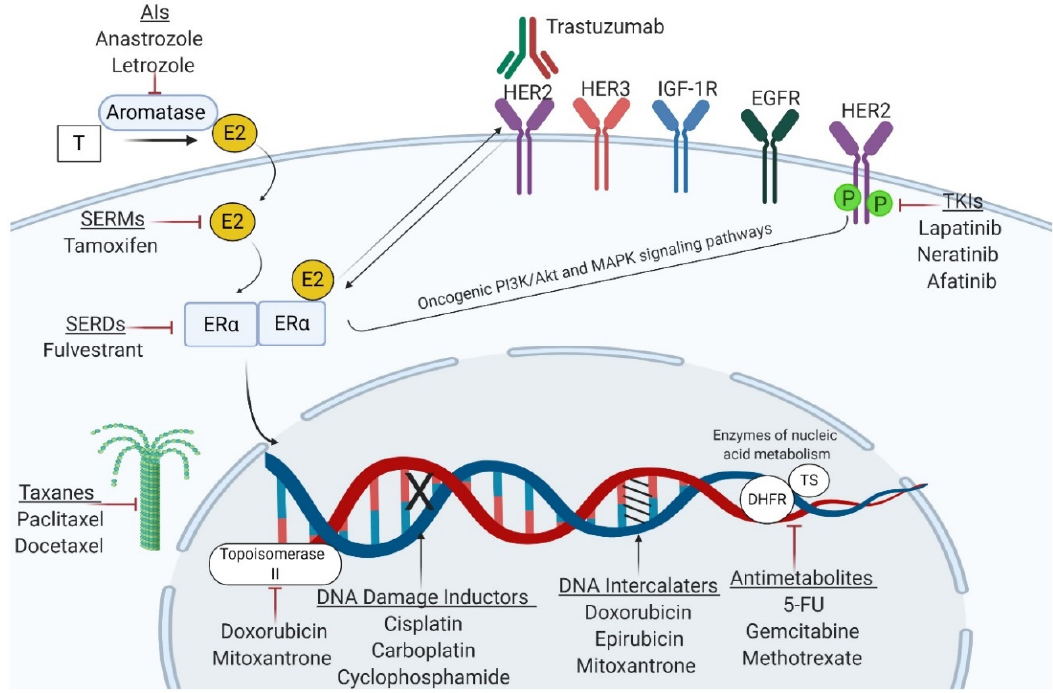
Figure 2. Mechanisms of action of the main classes of antineoplastic agents used in BC management. Endocrine therapies aim to interfere with ER α -associated signaling or decrease estrogen availability in the body, whereas trastuzumab and tyrosine kinase inhibitors (TKIs) are designed to block the HER2 receptor. Cytotoxic agents exert their anticancer effects through DNA damage (alkylating agents, platinum compounds), perturbation of nucleic acid synthesis (anthracyclines, taxanes, and mitoxantrone) or metabolism (antimetabolites). T—testosterone; E2—estradiol; ER α —estrogen